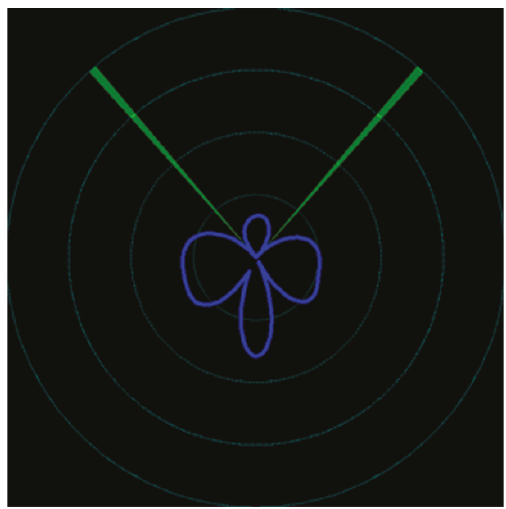
Figure 3: An example of the directional characteristics.